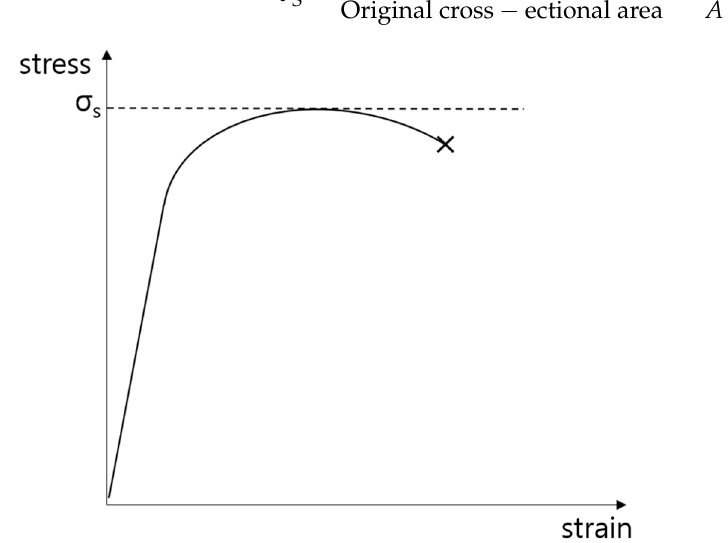
Figure 5. Strain–stress curve.